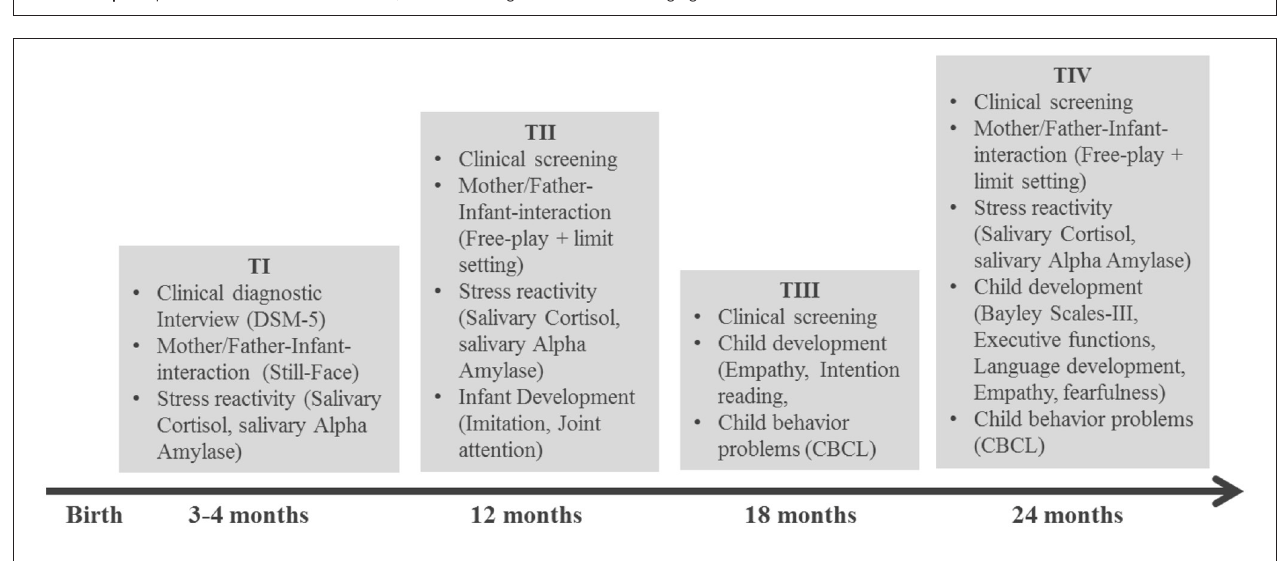
FIGURE 3 | COMPARE-interaction study